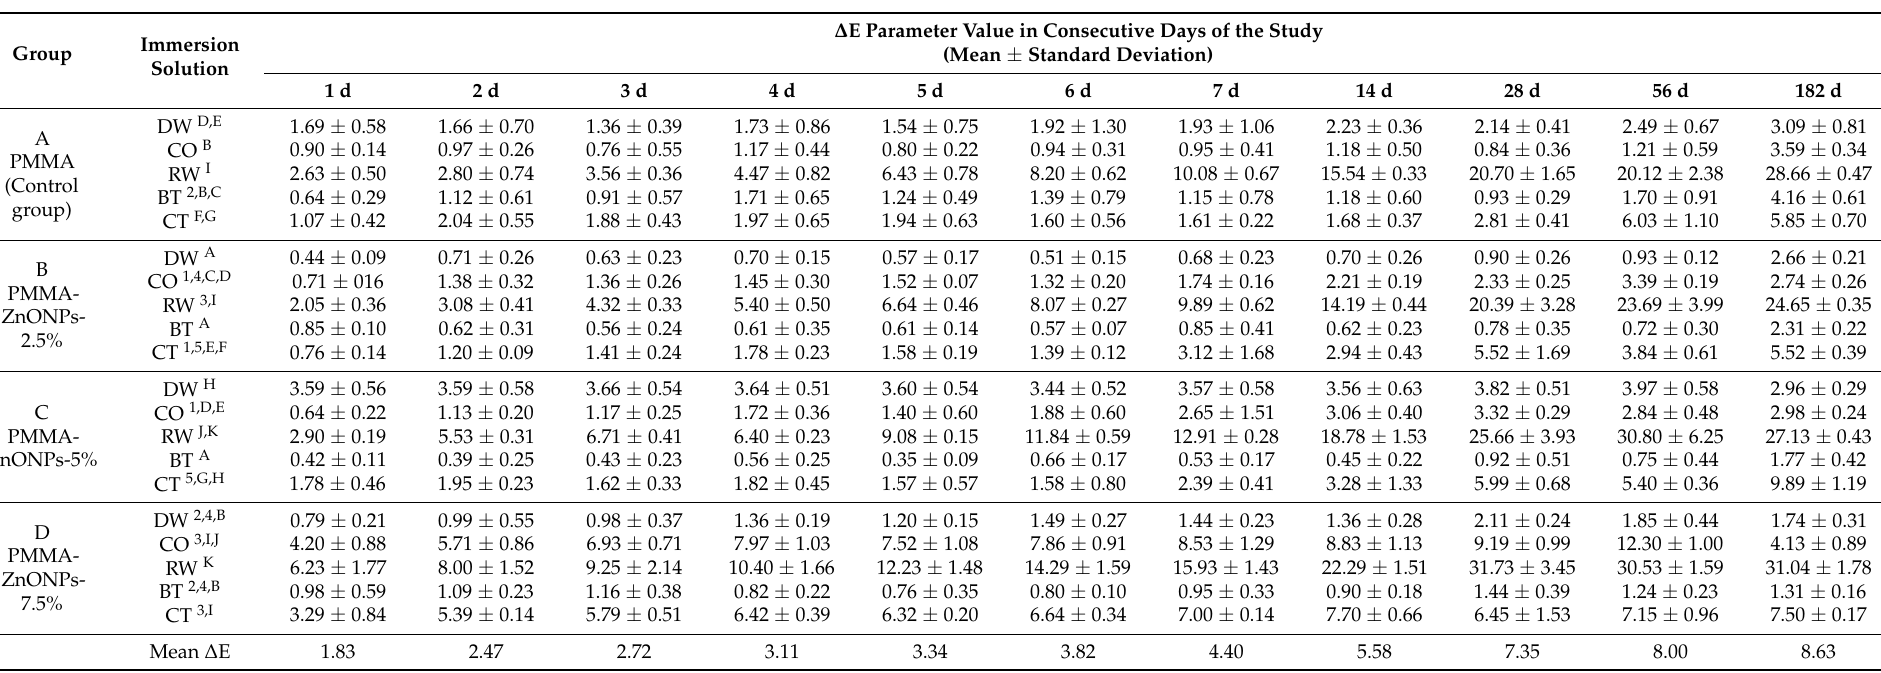
Table 2. Mean ± standard deviation of ∆ E parameter in relation to immersion solution and time of immersion with division into groups.